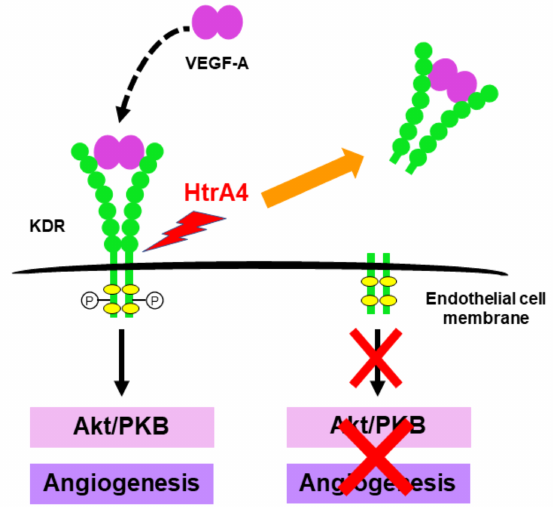
Figure 4. Predicted model of HtrA4 action in inhibiting VEGF-A function. VEGF-A binds to its cell surface receptor KDR to induce downstream Akt activity and endothelial cell function. HtrA4 cleavage of KDR prevents VEGF-A from eliciting downstream cell signalling and